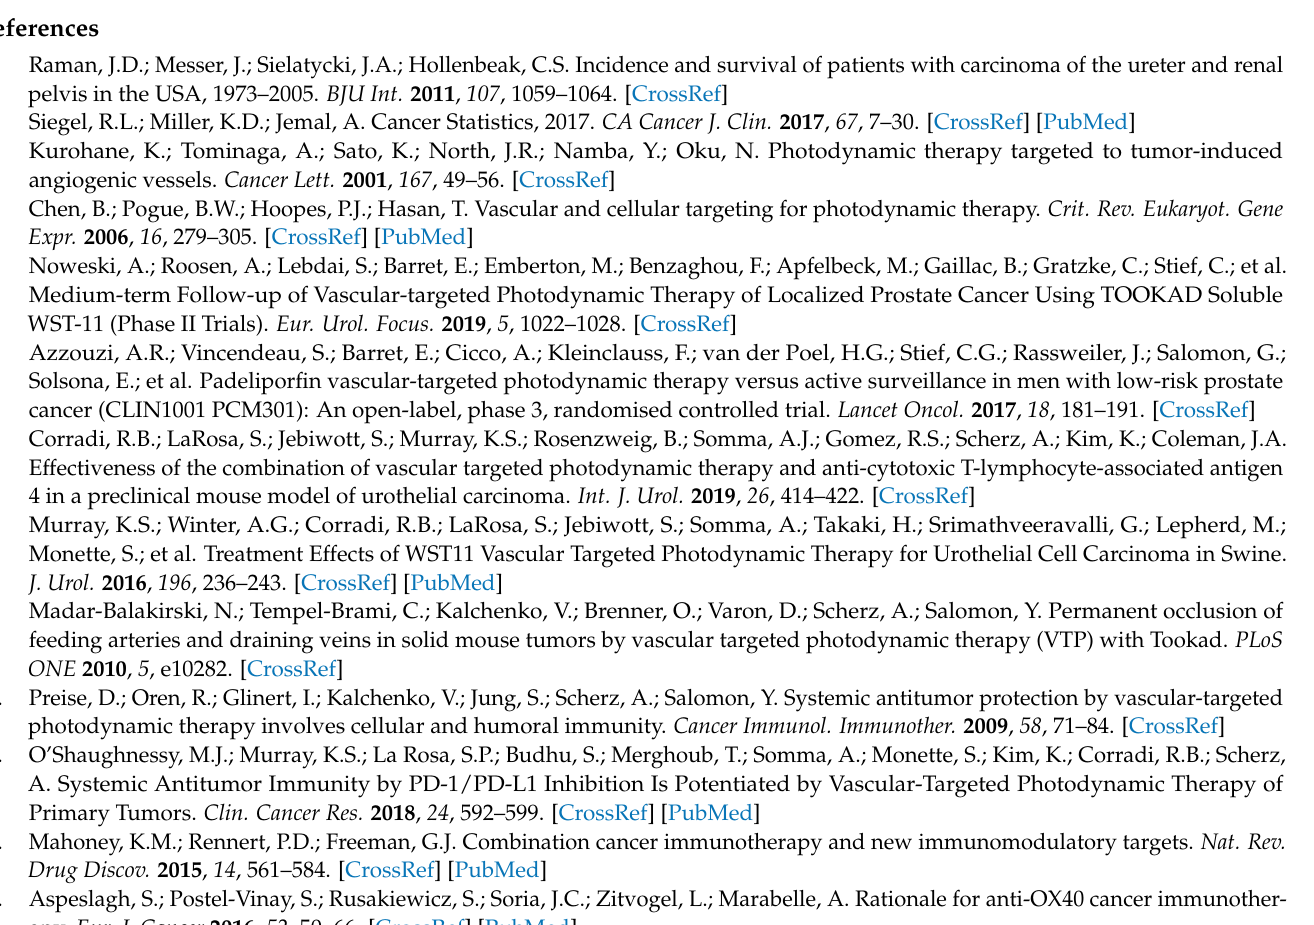
(IHC) for CD3, CD4, CD8. Figure S1: Growth patterns individed by VTP and no VTP groups. Figure S2: Metastatic signaling by IVIS following VTP Figure S3: Survival outcomes after VTP in the 4T1